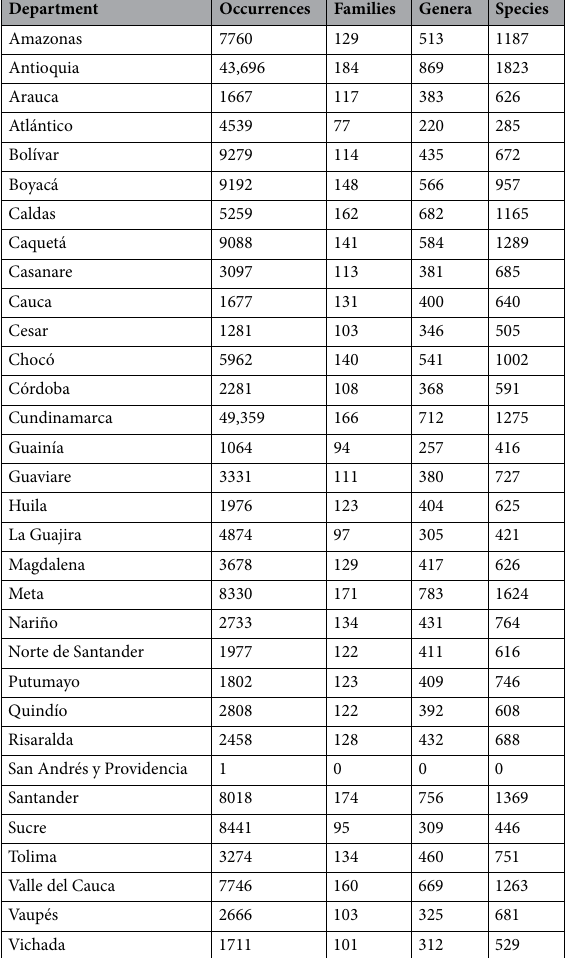
Table 2. Number of unique georeferenced records of edible species, species, genera and families recorded in each Colombian